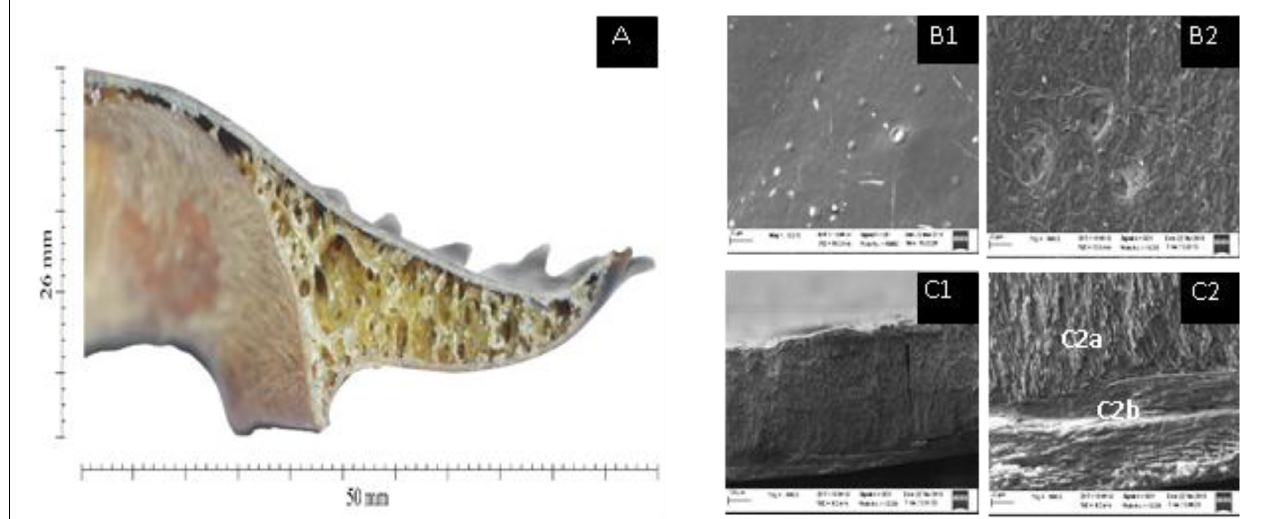
FIGURE 1 | Visual appearance of the incision through the opisthosoma of the shell of mangrove horseshoe crabs ( Carcinoscorpius rotundicauda ) with a foam-shaped structure of ± 70 µ m (A) . The microstructure of the horseshoe crab shell using SEM 500 × magnification at the top (B1) and bottom (B2) . 100 × magnification of transverse incision (C1) . 500 × magnification of transverse incision (C2) showing intermediate layer (C2a) and interior core (C2b)